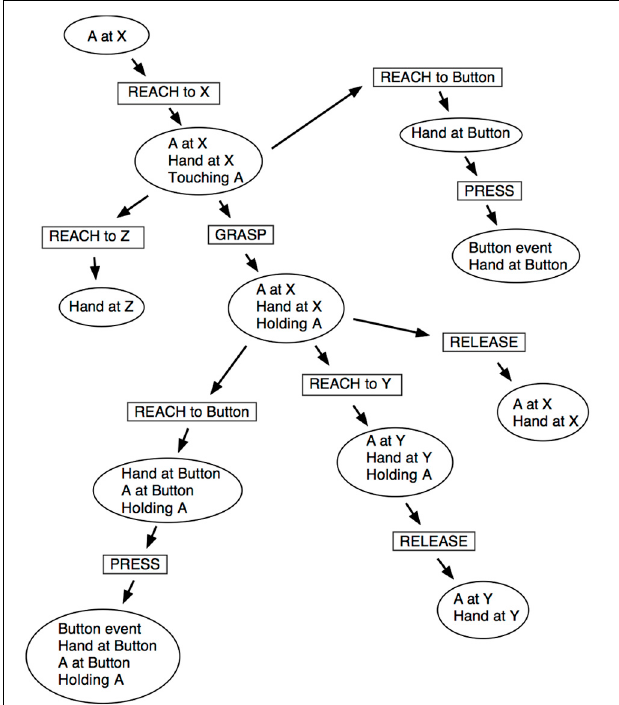
FIGURE 10 | A schematic map of some schema chaining possibilities. Rectangular boxes represent actions or state transitions and elliptical boxes represent different states known to the